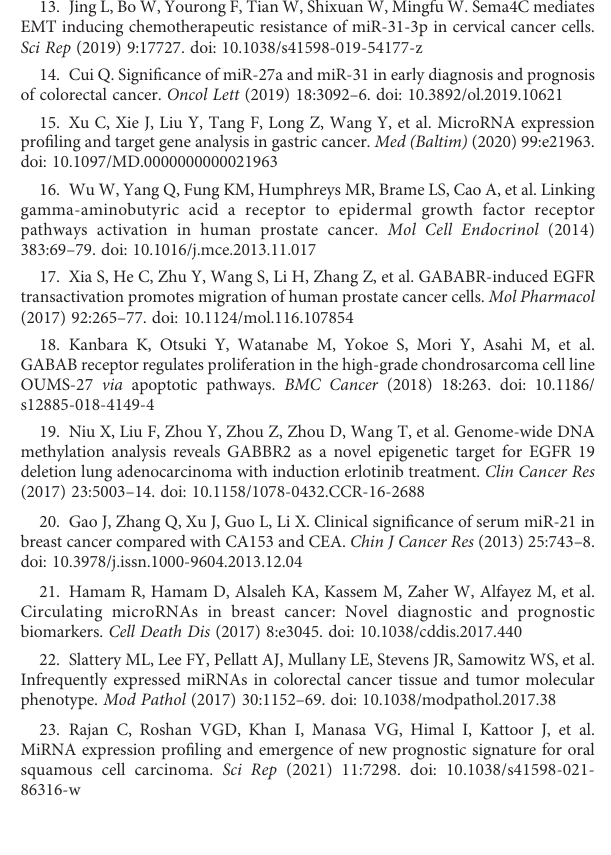
SUPPLEMENTARY FIGURE 1 Functional screening for miRNAs regulating PC cells growth. (A) miRNAs expression after transfection with indicated miRNA. Total RNA was prepared from transfected cells and indicated miRNA levels were analyzed by real-time polymerase chain reaction. RNU6B was used as the reference gene for normalization. An unpaired two-tailed Student ’ s t- test was used to calculate P values. Error bars represent mean ± standard error of the mean (SEM). ***P value < 0.001 vs. Cont (n = 3). (B) Representative image of morphology of PC cells transfected with the control miRNA, miR-4456, miR-646, miR-516a-5p, miR-941, miR-31-3p or miR-3181. (C) Identi fi cation of growth-inhibiting effects of miRNAs. Cell viability in cultured cells transfected with control miRNA, miR-4456, miR-646, miR-516a-5p, miR-941, miR-31-3p or miR-3181 was measured usingCellCounting Kit-8at72 h.Unpairedtwo-tailedStudent ’ st-testwas used to calculate the P value. Error bars represent mean ± SEM. **P value < 0.01 and ***P value < 0.001 vs. Cont (n=